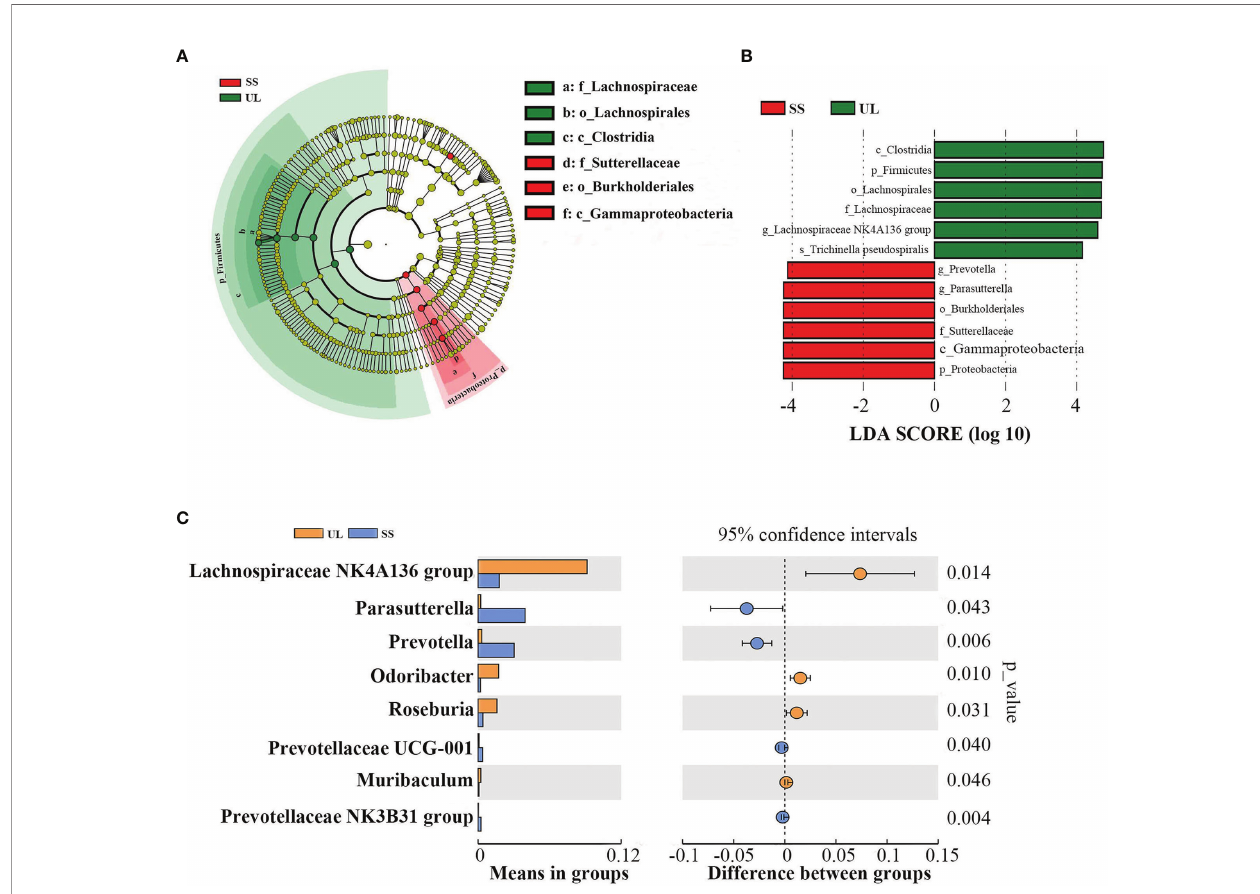
FIGURE 3 | Microbial community dynamics of the gut after unilateral labyrinthectomy. Cladogram representation of the gut microbiota in the UL versus the SS group by 16S rRNA sequencing (UL: n = 6, SS: n = 5). Enriched taxa in the UL (green) and SS (red) groups are indicated. The brightness of each dot is correlated with its LDA effect size (A) . LDA coupled with effect size measurements in the UL and SS groups. Enriched taxa in the UL (green) and SS (red) groups are displayed with LDA scores. Only taxa with LDA scores beyond the threshold of 4.0 are shown (B) . Statistical analysis of the gut microbiota in UL and SS groups by Student ’ s t-test (C) . UL, unilateral labyrinthectomy group; SS, sham surgery